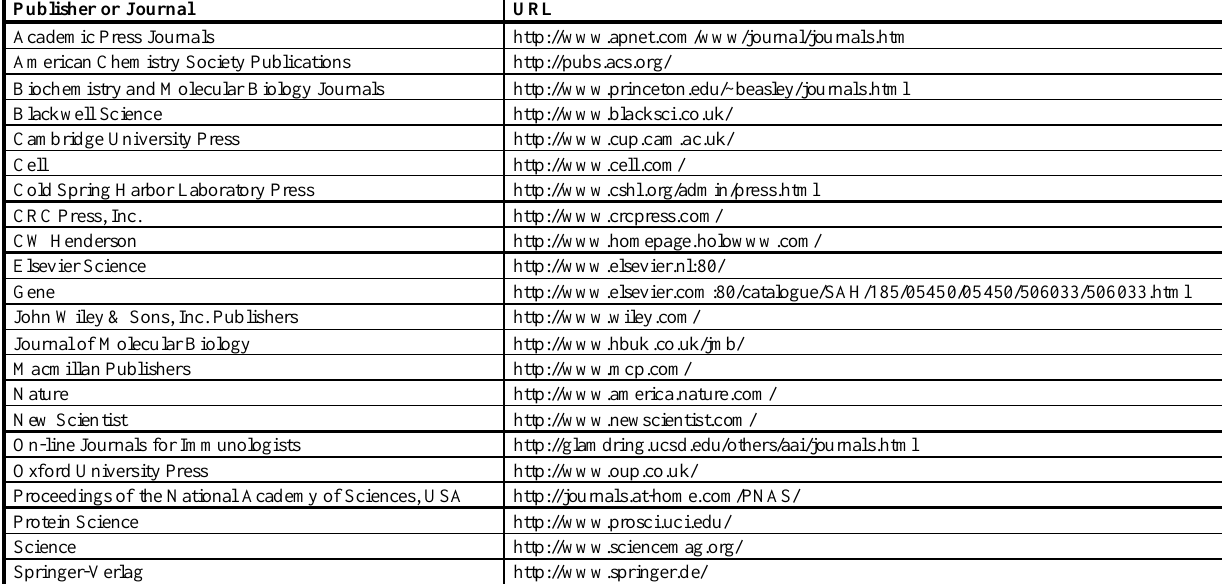
Table 5 - Publishers and scientific